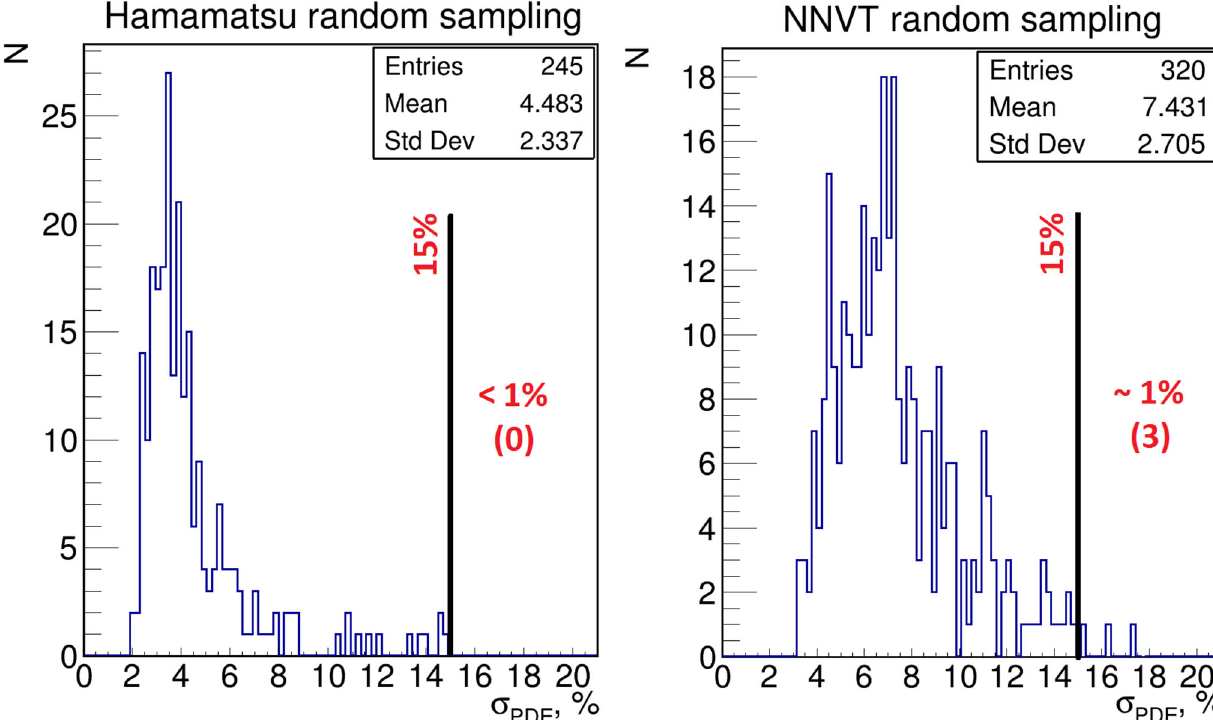
Fig. 39 PDE non-uniformity distributions for randomly sampled PMTs. Black lines show the threshold for PDE non-uniformity (15%), numbers in brackets indicate failed PMTs. Left: HPK (Hamamatsu) PMTs; right: NNVT PMTs